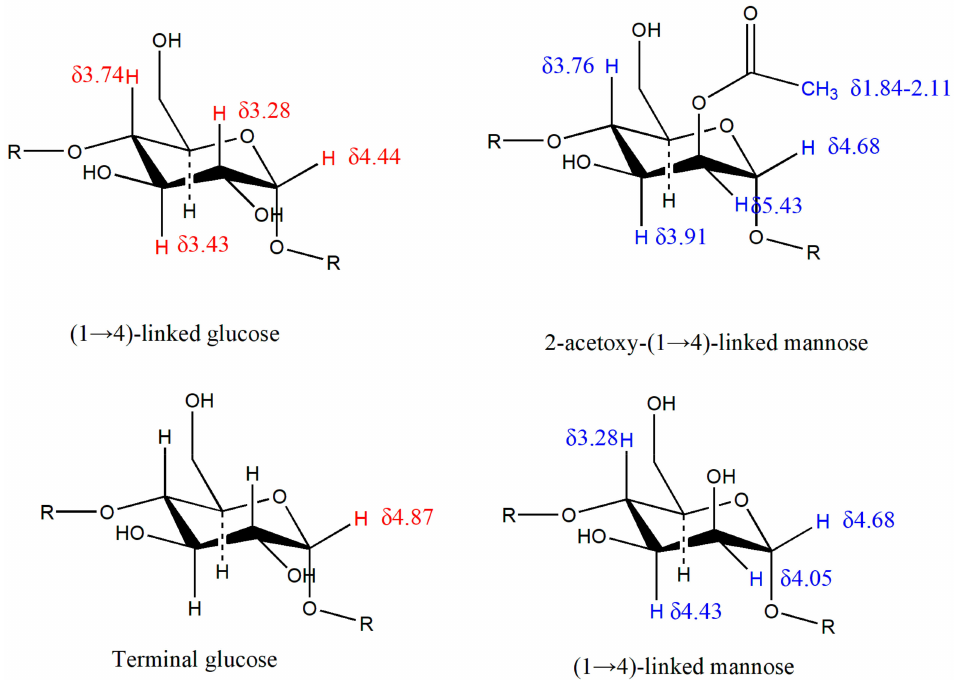
Figure 5. The attributed chemical shifts of all